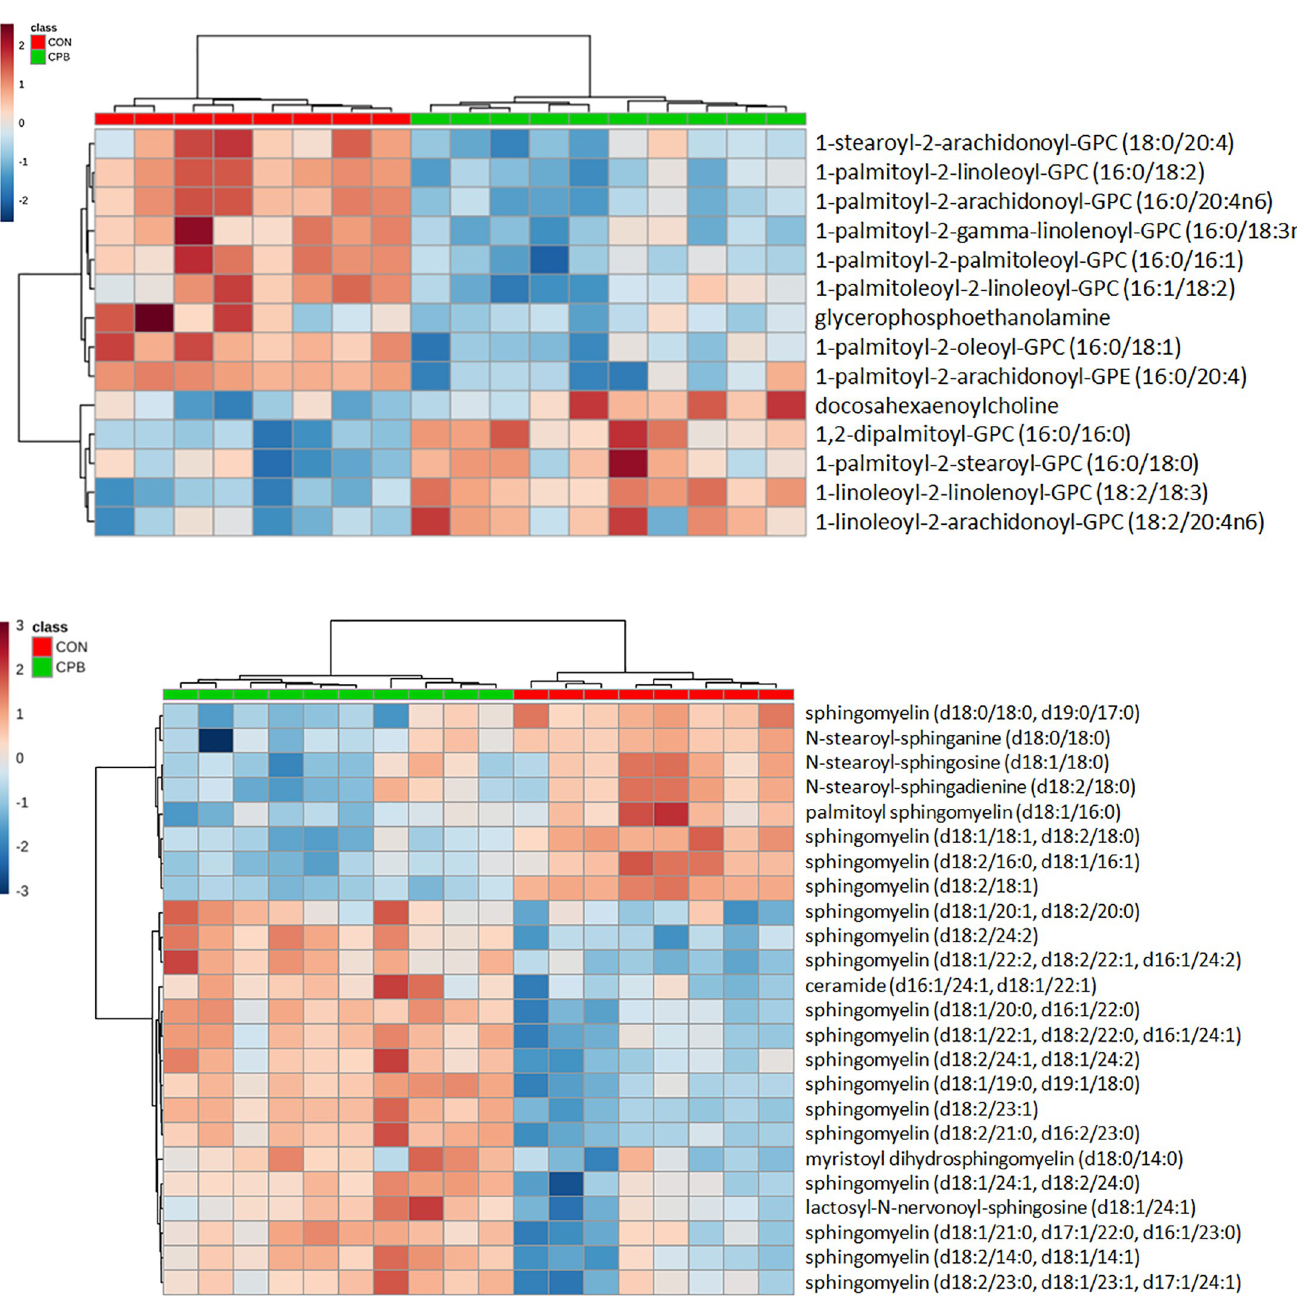
1-acyl position. Three of the identified plasmalogens were GPC while the other three belonged